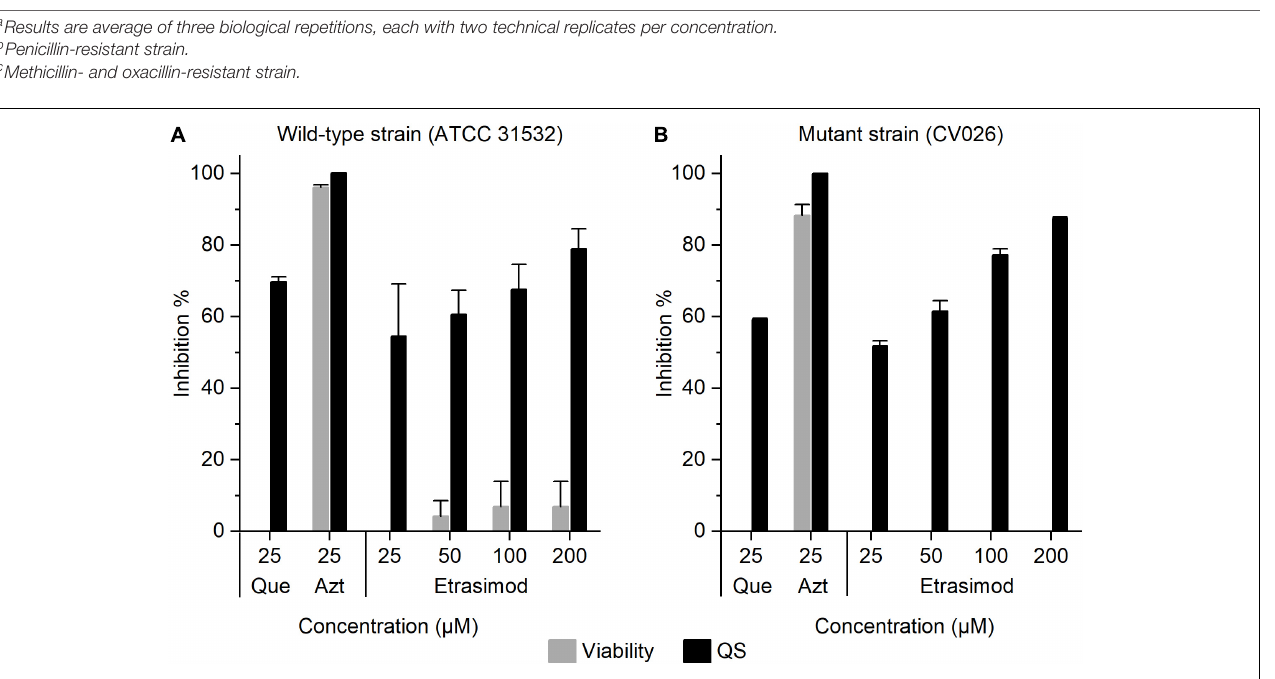
FIGURE 5 | Inhibition of the viability and QS activity of Chromobacterium violaceum (A) wild-type strain (ATCC 31532); and (B) mutant strain CV026 by etrasimod, quercetin (Que, QSI control) and azithromycin (Azt, bactericidal control). The results are expressed as the inhibition percentage ± SD. The experiment was repeated with two biological repetitions, each with two replicates per